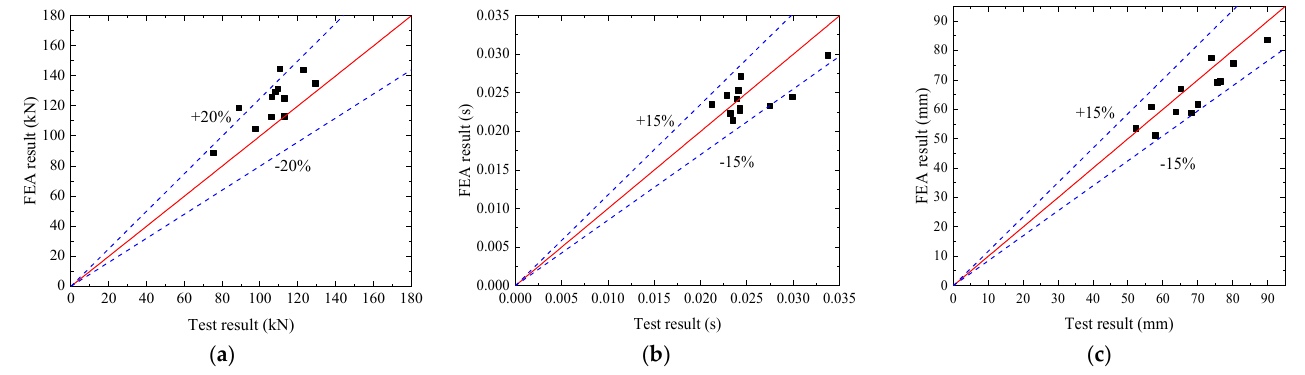
Figure 7. Comparisons between the plateau values ( F stab ), load durations ( t ) of the impact forces and the mid-span deflections ( Δ ). ( a ) Plateau value ( F stab ); ( b ) Load duration ( t ); ( c ) Mid-span deflection ( Δ ).